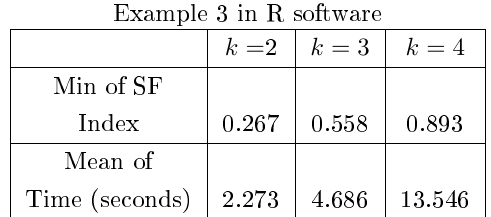
non - hierarchical algorithm for 121 PDFs in